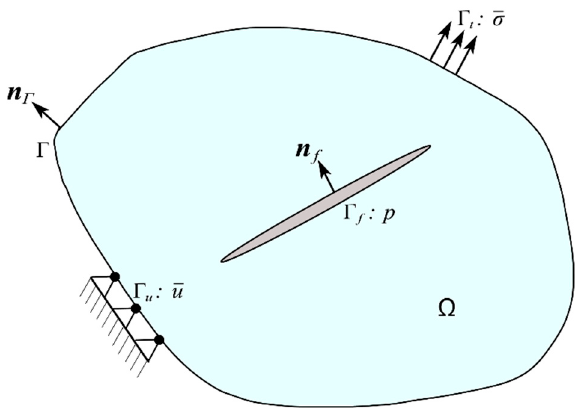
Figure 3. Illustration of a domain .